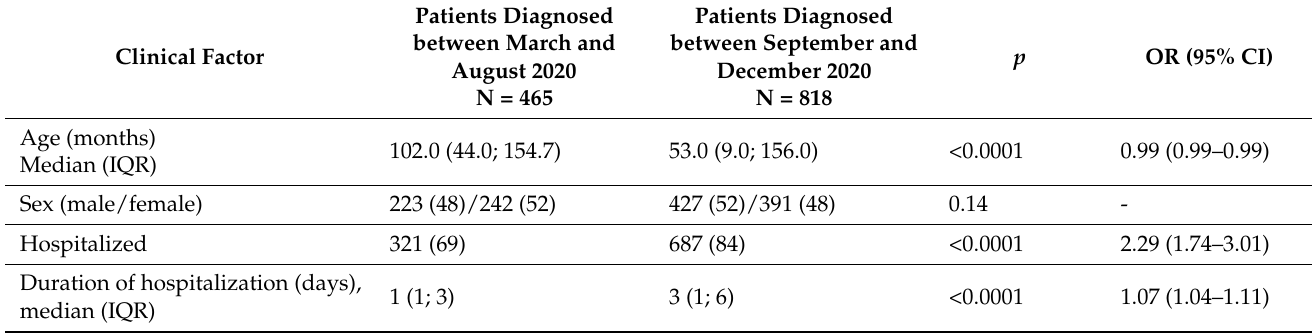
Table 4. Comparison of the clinical presentation of COVID-19 in children between the 1 st and 2 nd waves of the pandemic.